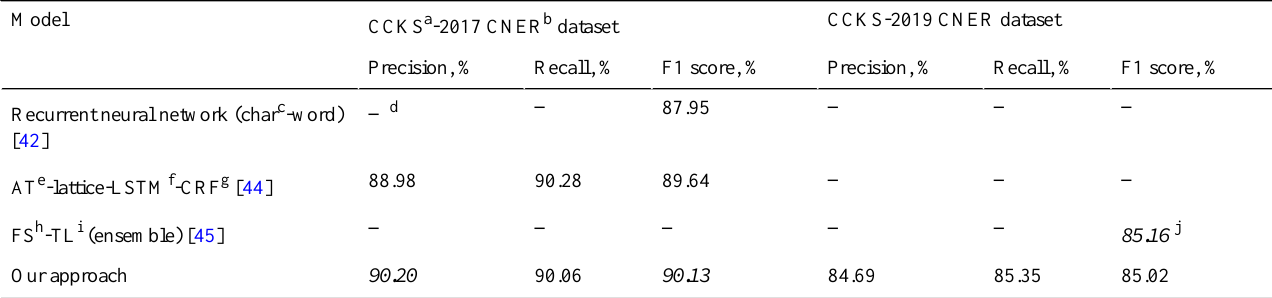
Table 5. Comparative results between our approach and previous systems on two